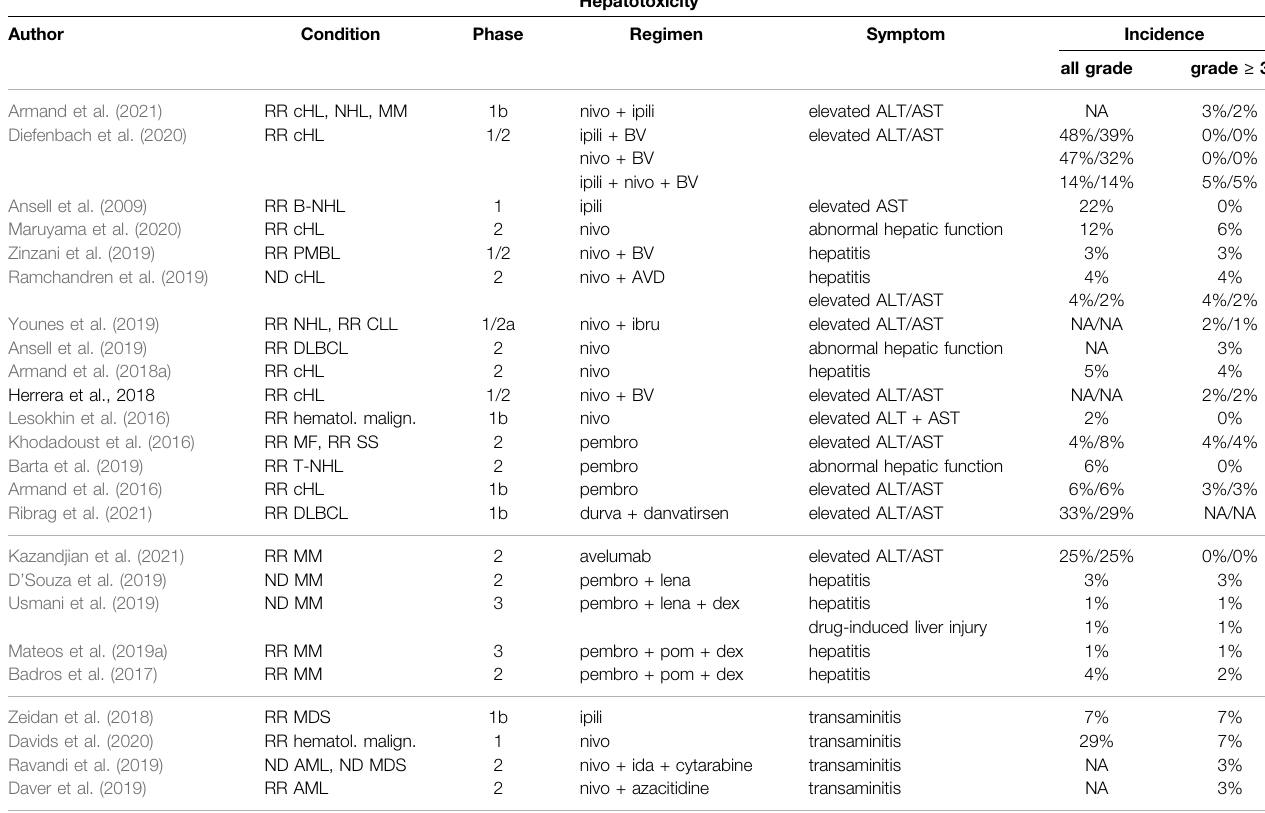
TABLE 3 | Incidence of hepatic irAEs in hematological